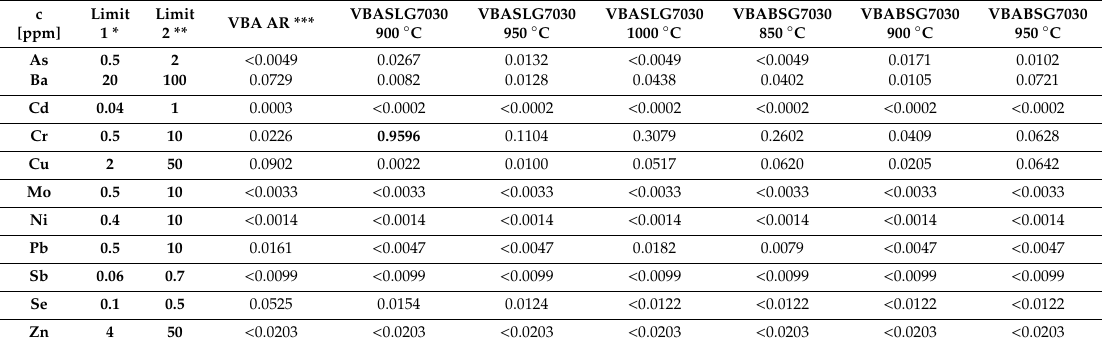
Table 3. Results of the leaching tests performed on the VBA-based glass-ceramic foams. Concentrations are listed in ppm. Concentrations in bold exceeded the limiting values for inert